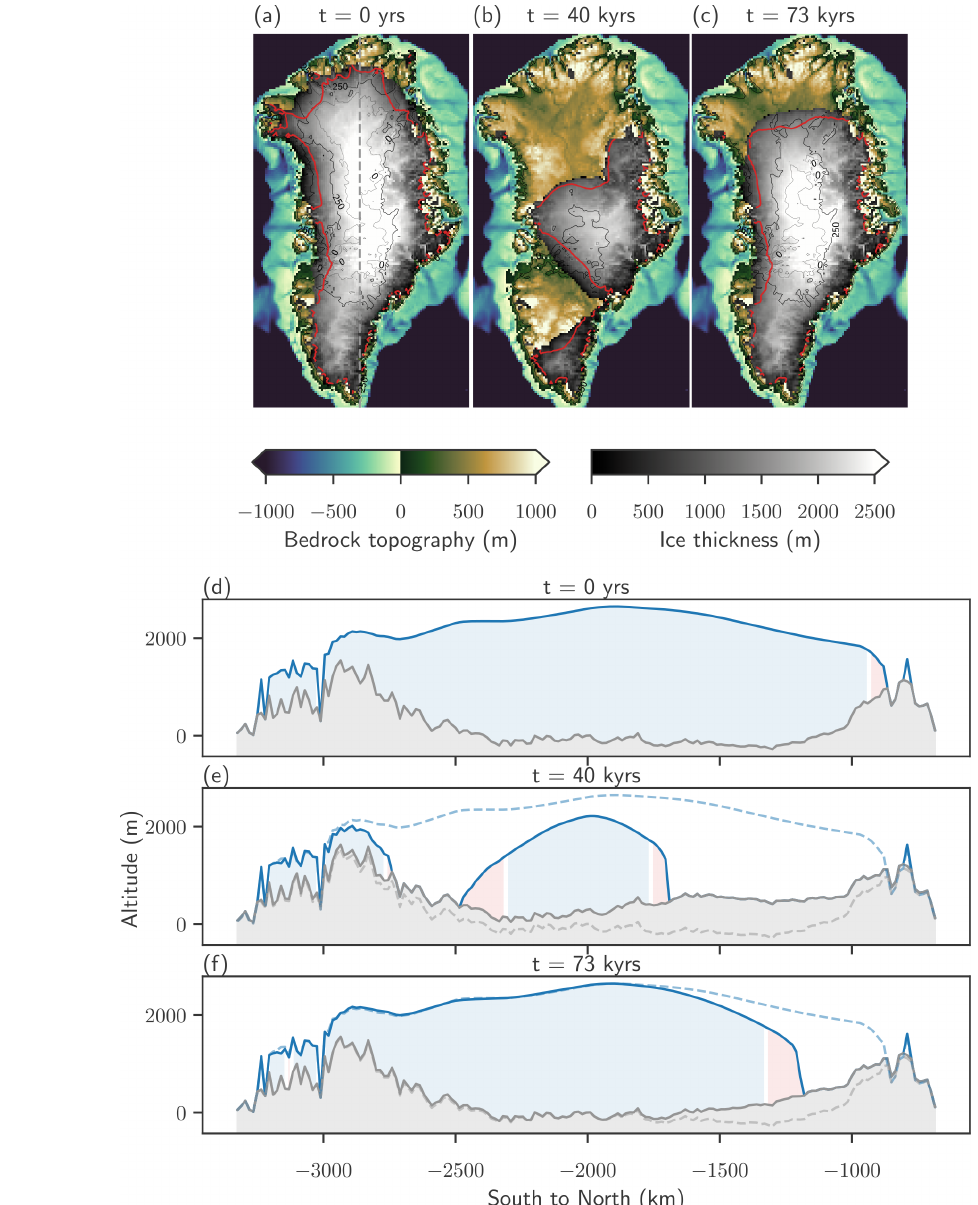
Figure 3. Spatial distribution of ice thickness at a temperature anomaly of (cid:49)T = 2K for the parameters η = 1 × 10 21 Pas and (cid:48) = 6Kkm − 1 . Maps and cross sections of the bedrock topography and ice thickness show the initial state at the start of the simulation (a, d) , the state with minimal volume after 40kyr (b, e) and the recovered state after 73kyr (c, f) . The red outline and the red shaded areas indicate the ablation regions. The dashed lines in (e) and (f) show the initial topography of the ice